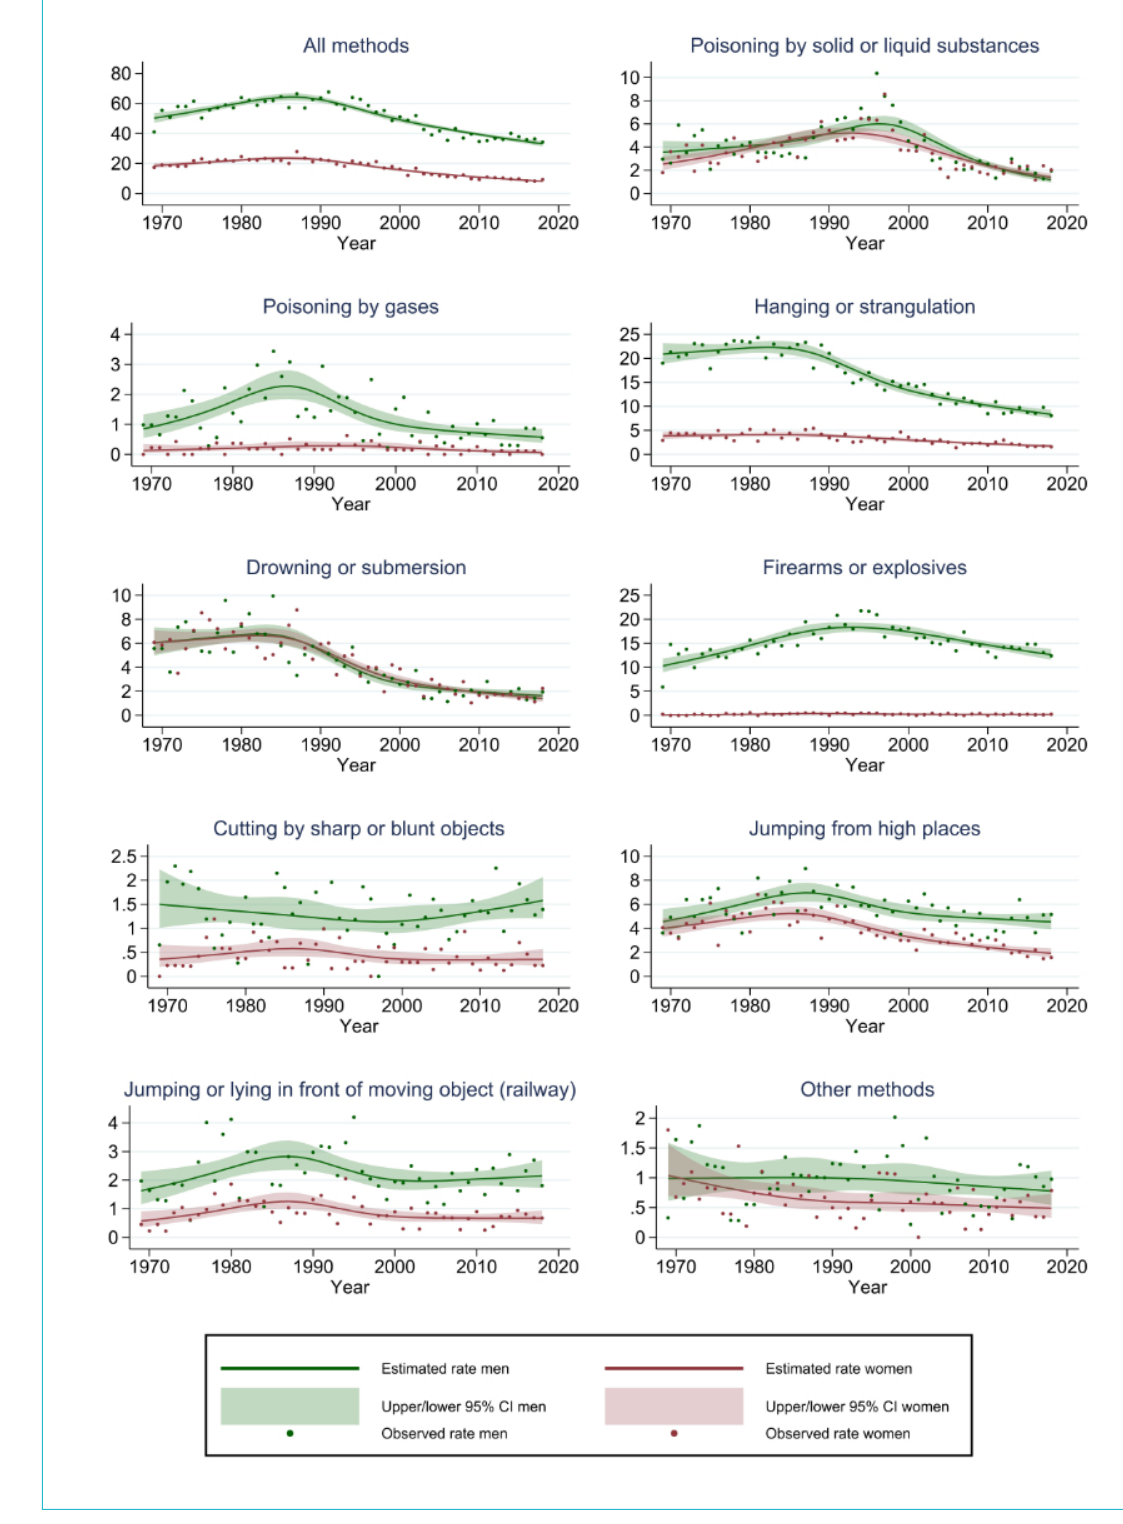
Figure 4: Rates of suicide methods per 100,000 population (person-years) in the age group 65 or more years. Note: estimated true rates and associated confidence intervals (CI) were derived from Poisson regressions using a restricted cubic-spline